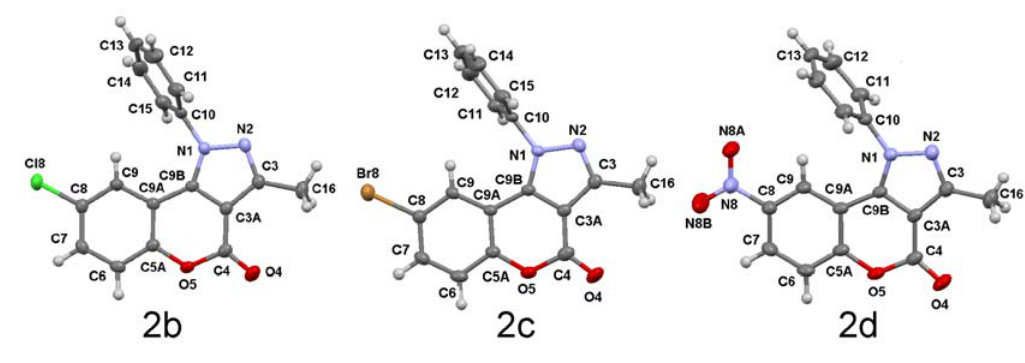
Figure 1. The molecular structures of 2b-d , from left to right, showing the atom-labelling scheme. Displacement ellipsoids are drawn at the 30% probability level and H atoms are shown as small spheres of arbitrary